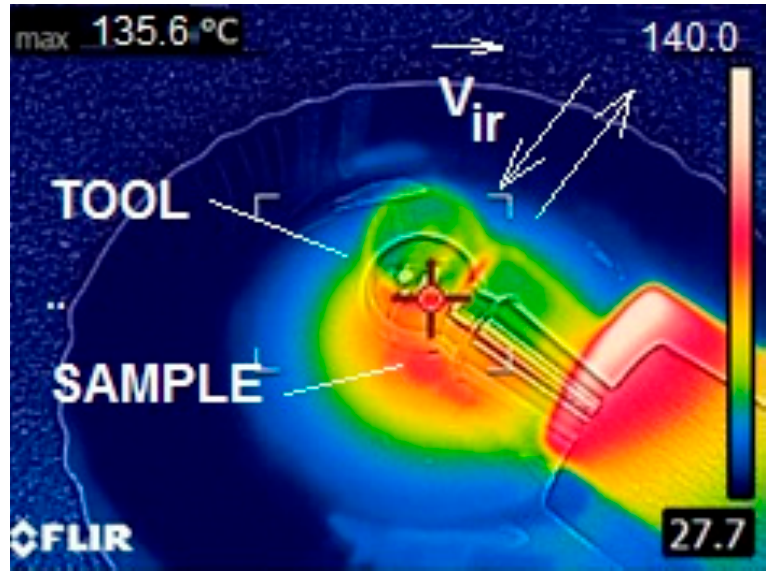
Figure 22. The infra ‐ red view on the experimental ironing of the machined surface.